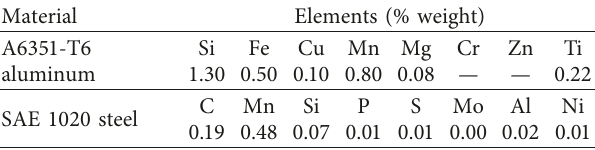
Table 1: Chemical composition of the materials